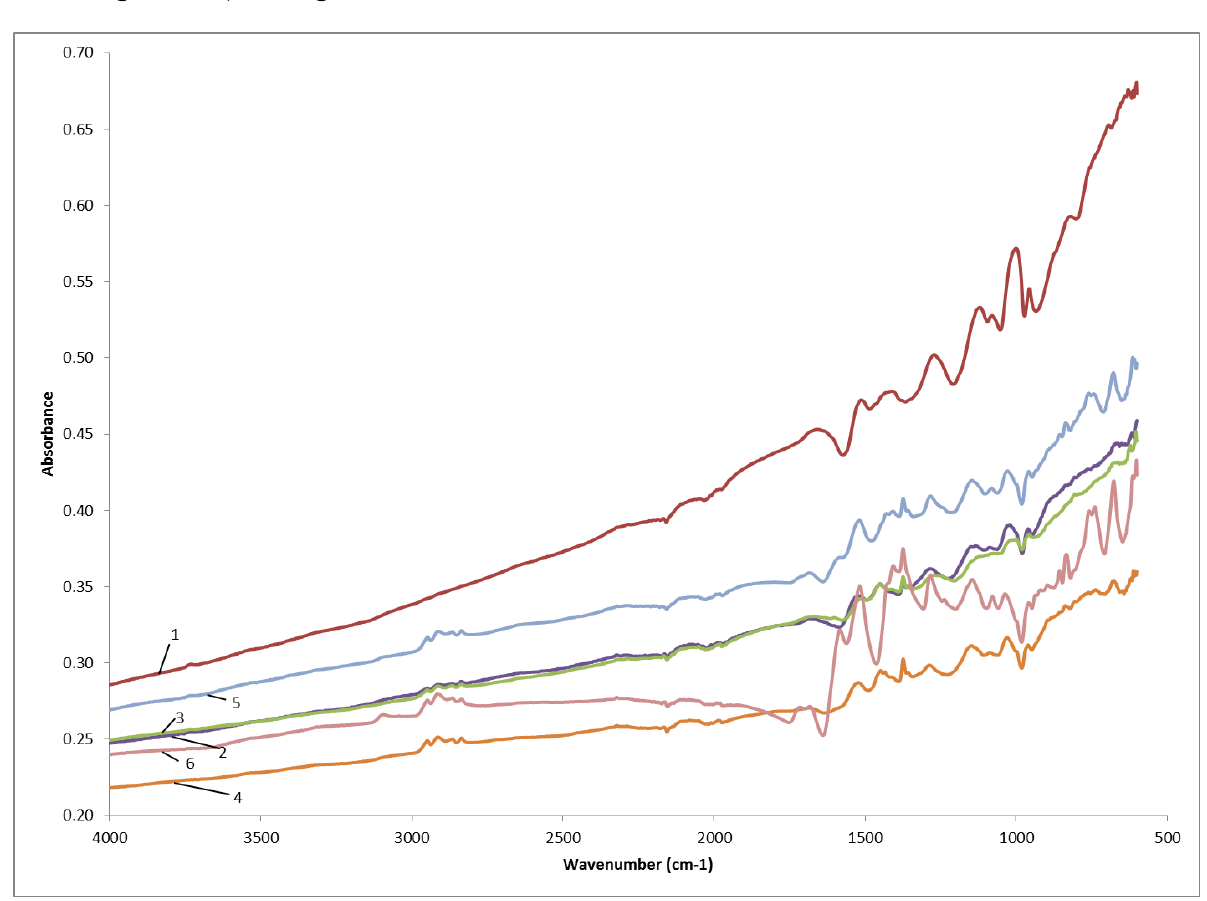
Figure 4. Averaged FTIR spectra for polypyrrole coating with the addition of various concentrations of 3TAA: 0 mg/mL (1); 1 mg/mL (2); 10 mg/mL (3); 20 mg/mL (4); 50 mg/mL (5); 100 mg/mL